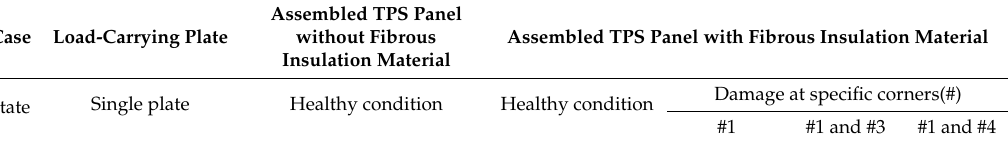
Figure 3. Testing structure. ( a ) the healthy condition of the TPS panel: a torque value of 4 N · m was maintained for four bolted joints at four corners, ( b ) a typical bolted joint in healthy condition, ( c ) a typical case of damaged bolted joint at zero torque value. Table 2. Experimental cases for dynamic characteristics and damage states of the TPS